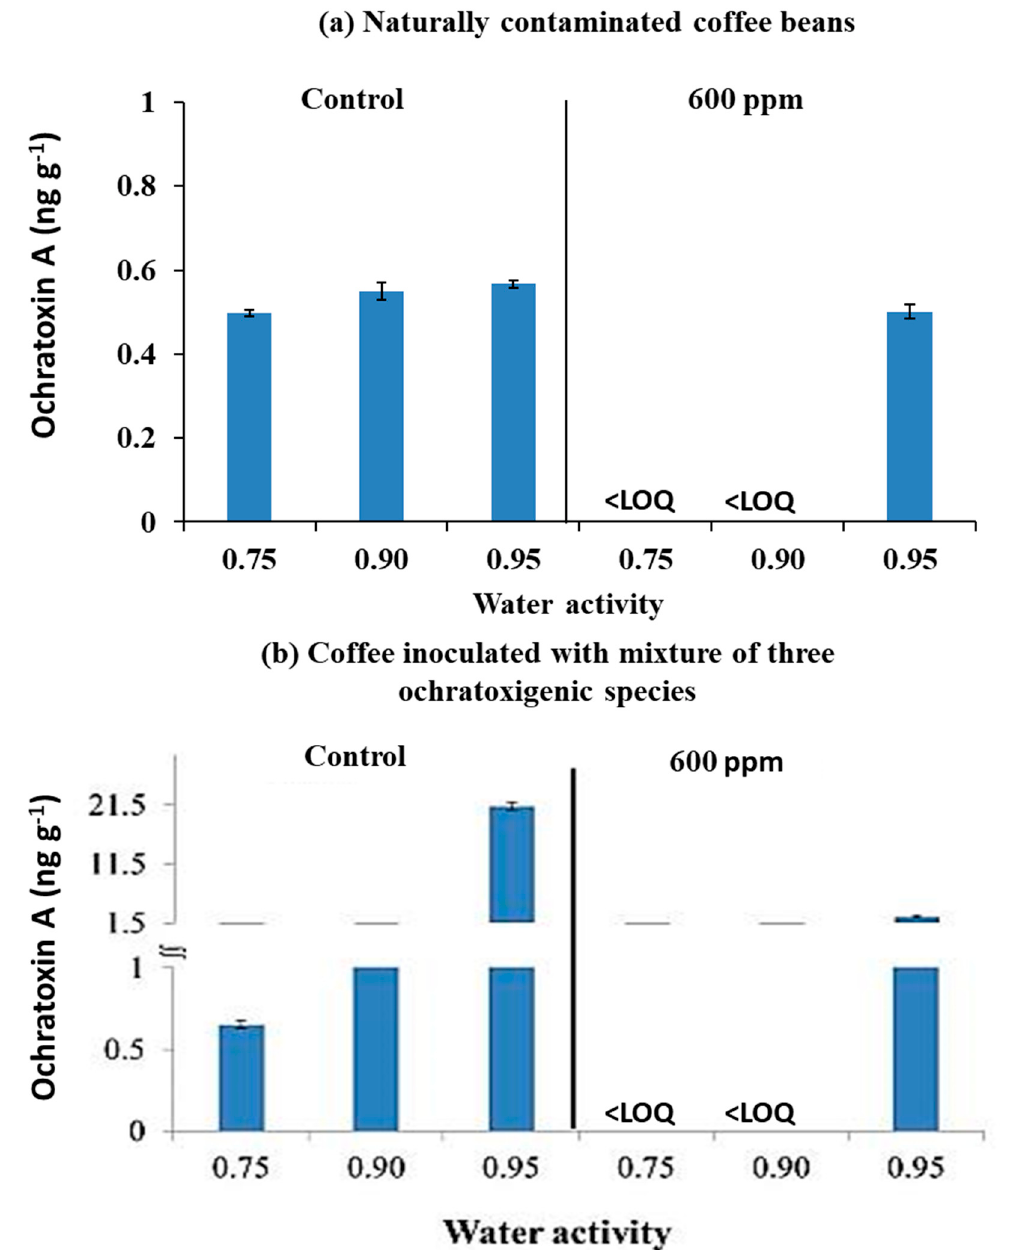
Figure 4. Combined effect of 600 ppm O 3 x a w (0.98 and 0.94) on ochratoxin A production in ( a ) naturally contaminated coffee beans and ( b ) coffee beans inoculated with conidia of 3 ochratoxigenic species when stored for 30 °C for 12 days. Vertical bars indicate the standard error of the means. Key: <LOQ, less than Limit of Quantification.